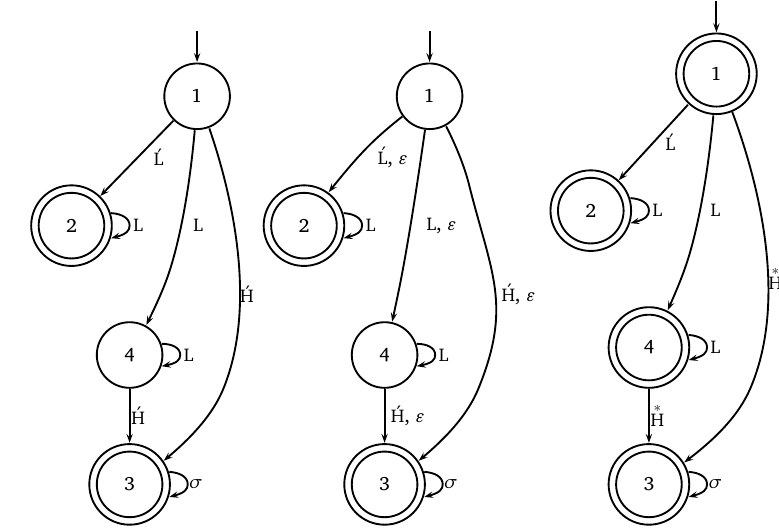
Figure 2: The application of the subsequence closure algorithm to Amele. At left, the normalised DFA representing Amele itself; in centre, the addition of ϵ -edges; and at right, the normalised